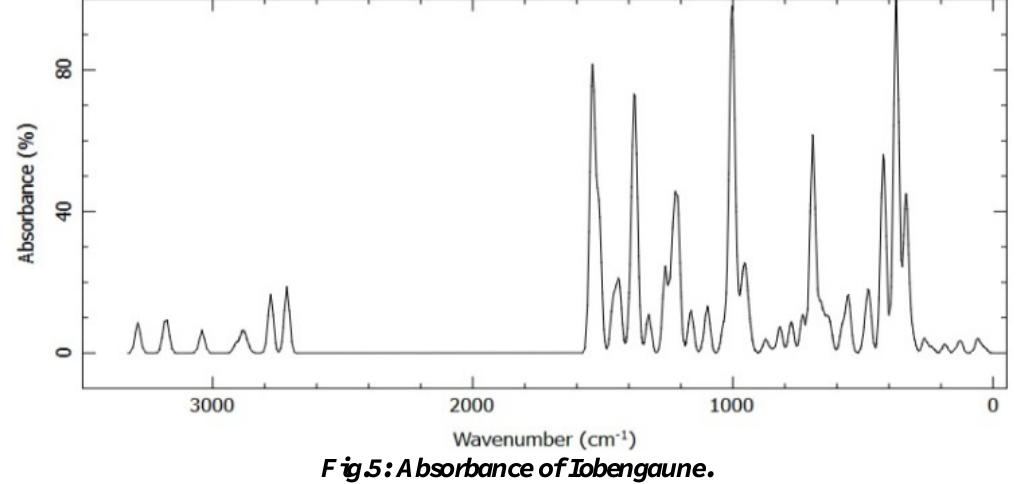
Fig.5: Absorbance of